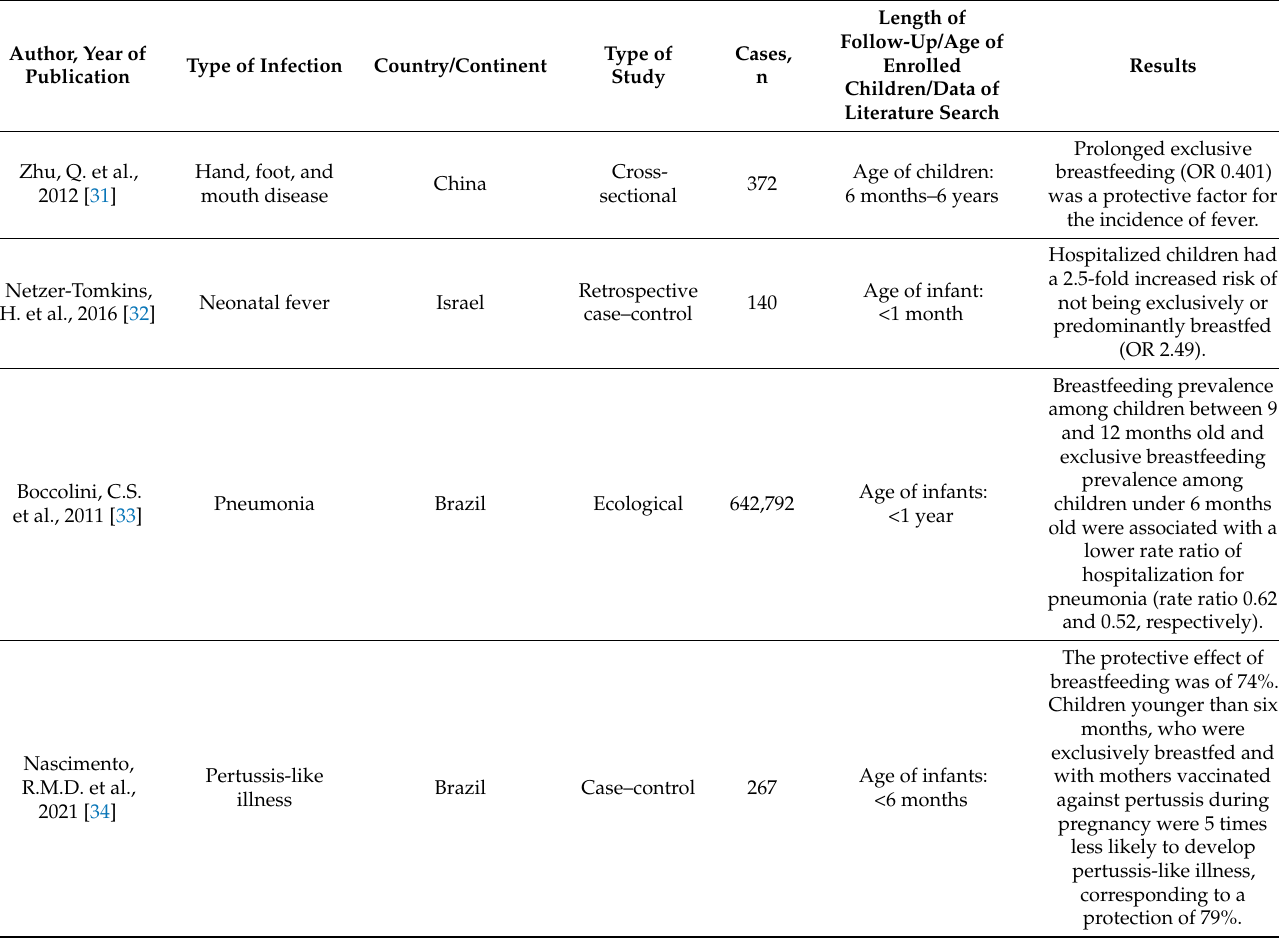
Table 1. Studies that evaluated the association between breastfeeding and infection risk in